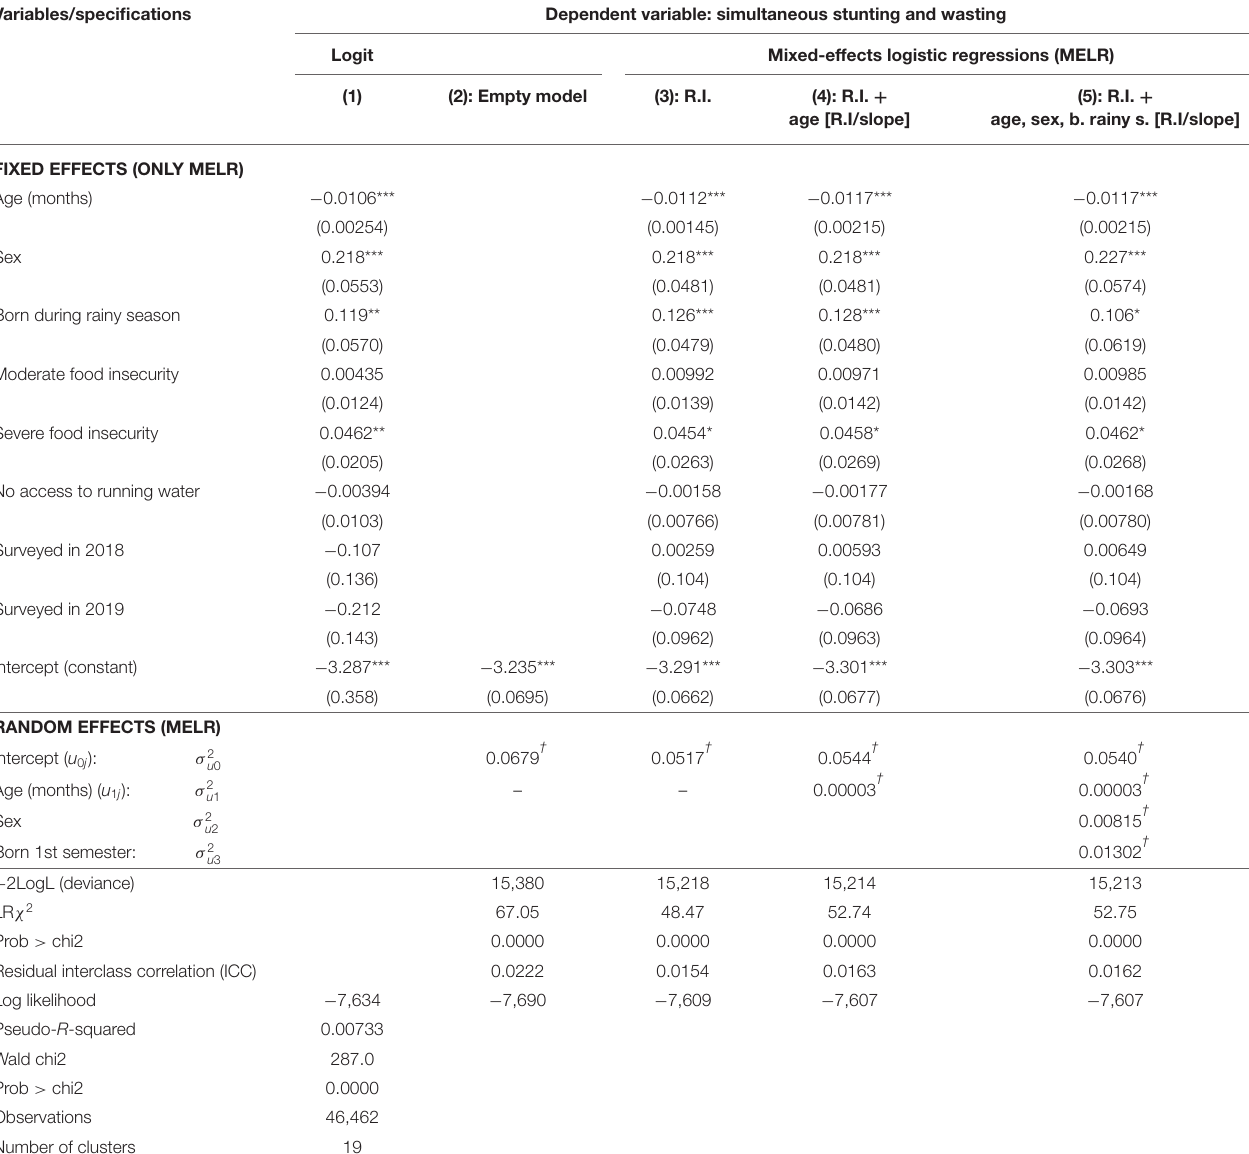
TABLE 7 | Logit and multilevel logistic regression specifications for the probability of being simultaneously stunted and wasted (concurrence).